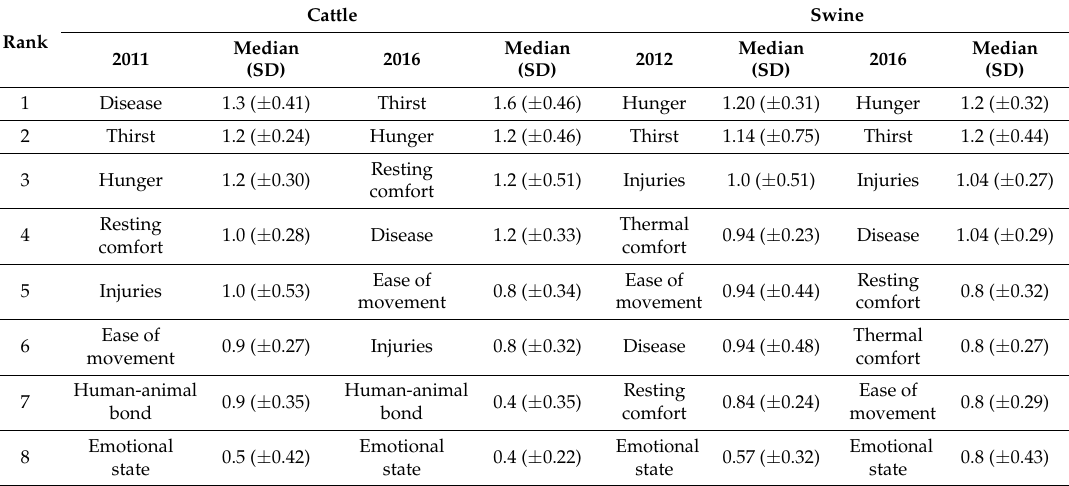
Table 3. The prioritization of welfare criteria rated by Danish experts for cattle and swine participating in four online surveys on animal welfare in 2011, 2012 and